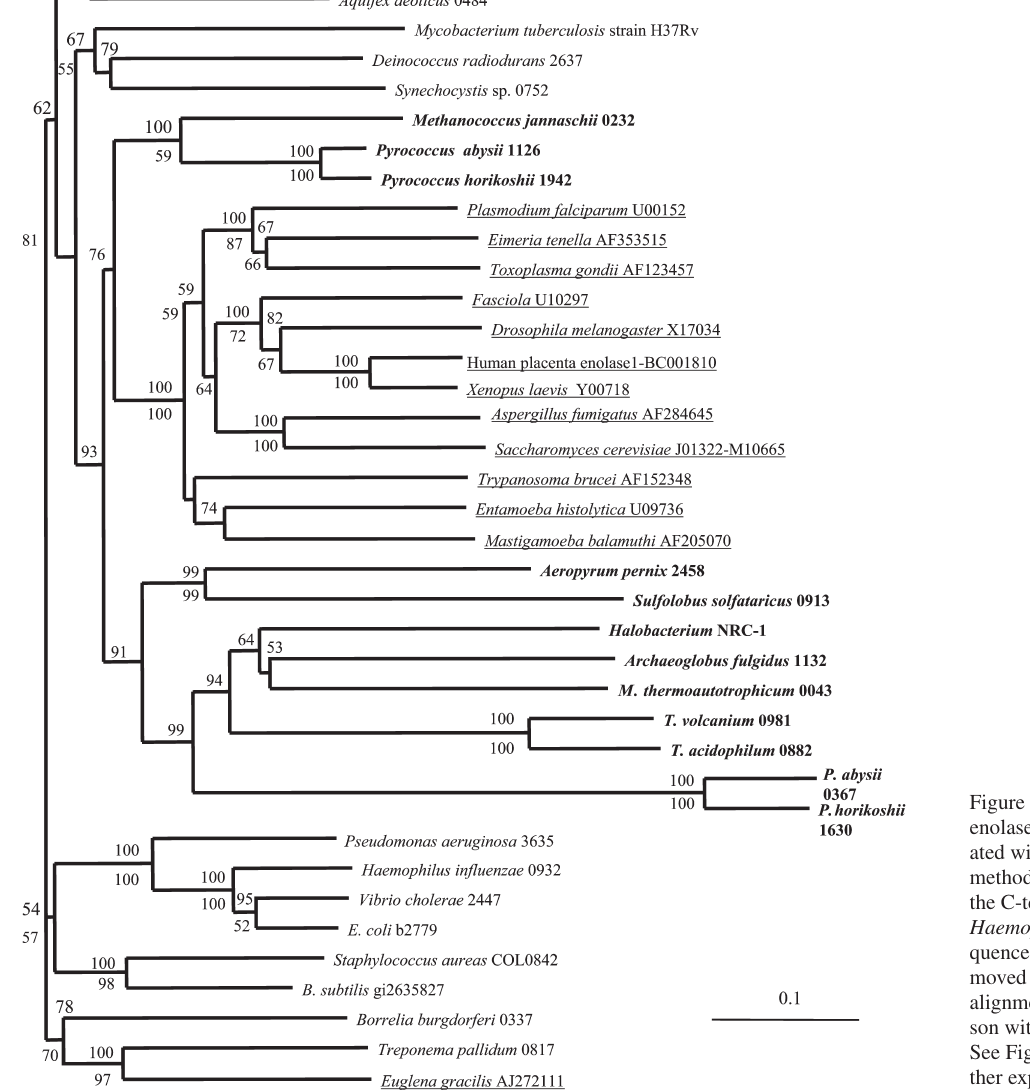
Figure 4. Phylogenetic tree of enolases (EC 4.2.1.11) gener- ated with the neighbor-joining method. Three residues within the C-terminus of the Haemophilus influenzae se- quence (419–421) were re- moved to maintain the alignment based on compari- son with crystal structure data. See Figure 1 caption for fur- ther